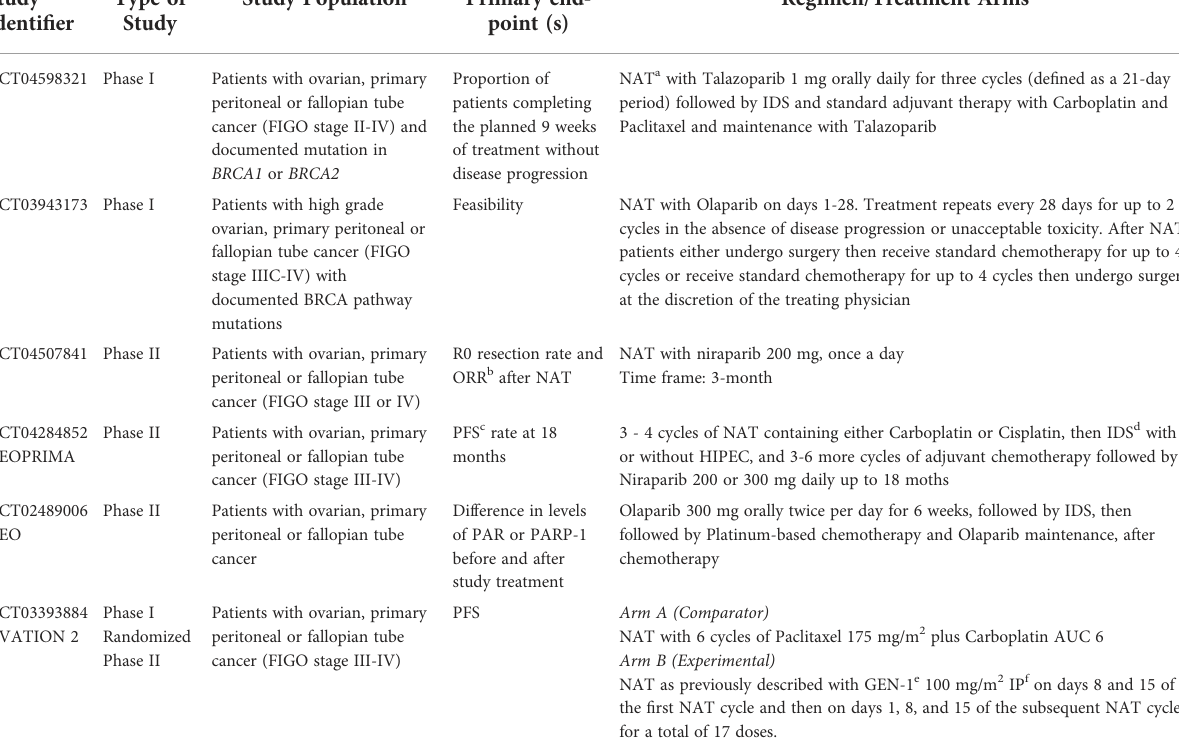
TABLE 4 Selected current clinical trials investigating the role of PARP inhibitors in the neoadjuvant setting. Study Identi fi